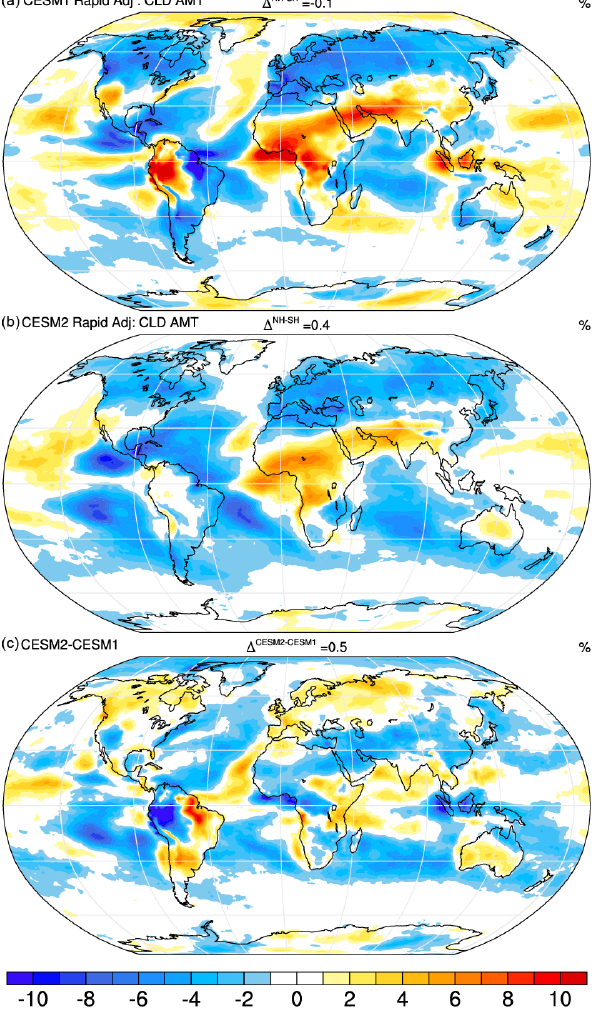
Figure A3. Rapid adjustments of cloud amount (%) to CO 2 based on 4 × CO 2 AMIP–AMIP simulation differences in (a) CESM1, (b) CESM2, and (c) their difference ( a minus b ).